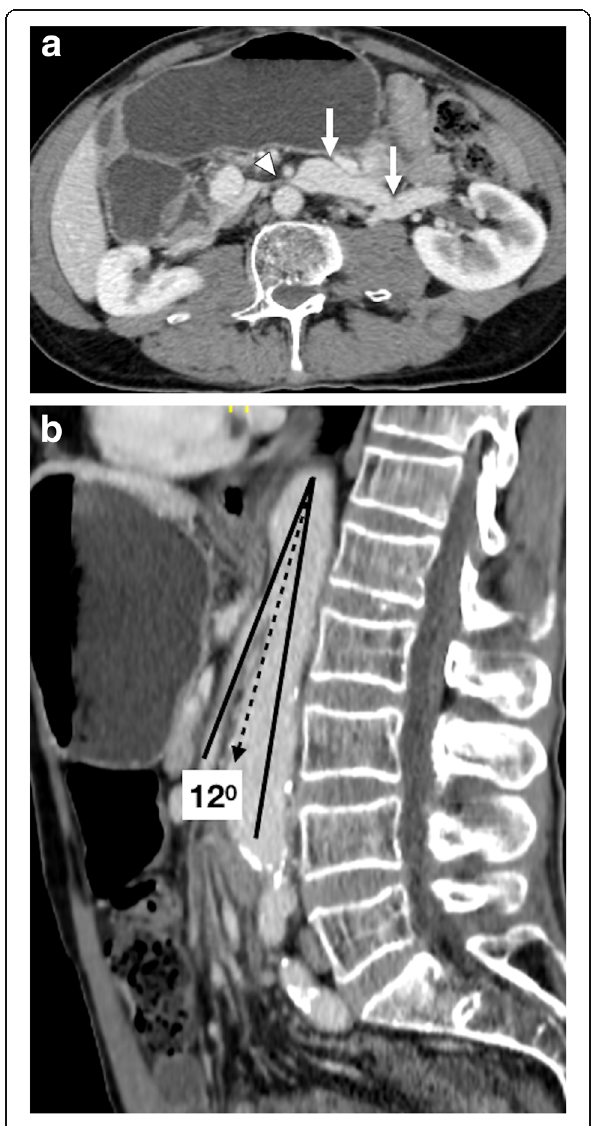
Fig. 19 Nutcracker syndrome. A 67-year-old male with known aortic aneurysm presented to ED with gross hematuria. The sonographic examination of the abdomen was unremarkable. a Axial plane venous phase CT image shows significant distension of the left renal vein (arrows) with severe and abrupt narrowing in the preaortic area (arrowhead). b The aortomesenteric angle was measured to be 12°. There was no evidence of urinary stone disease or TCC in the same exam. The patient was placed on conservative therapy